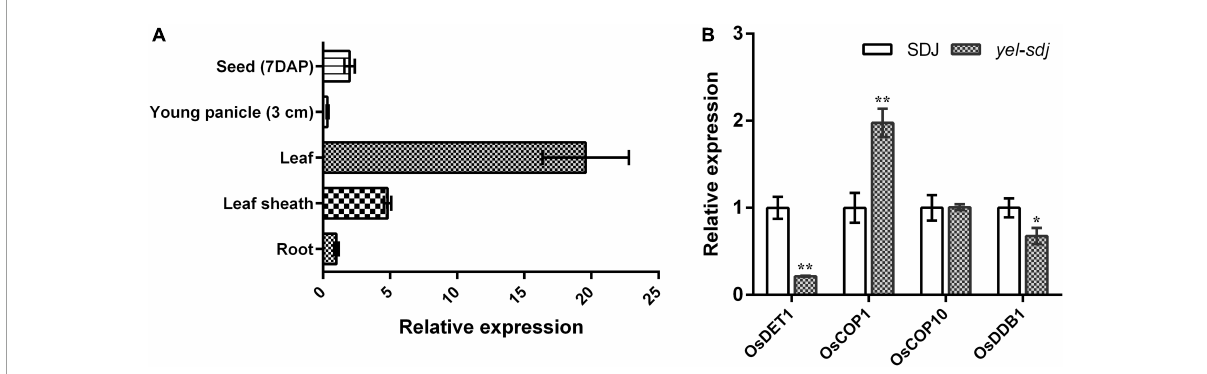
FIGURE5 Expression analysis of OsDET1 and yel phenotype-associated genes. (A) Quantitative real-time PCR (qRT-PCR) analysis of OsDET1 in various organs of SDJ (WT). (B) Relative expression levels of yel phenotype-associated genes in the developing seeds of SDJ (WT) and yel - sdj mutant at 7 days after pollination (DAP). Expression level of genes was normalized relative to that of ACTIN . Data represent mean ± SD of three biological replicates. Asterisks indicate statistical significance, as determined by Student’s t -test (* p < 0.05, ** p <